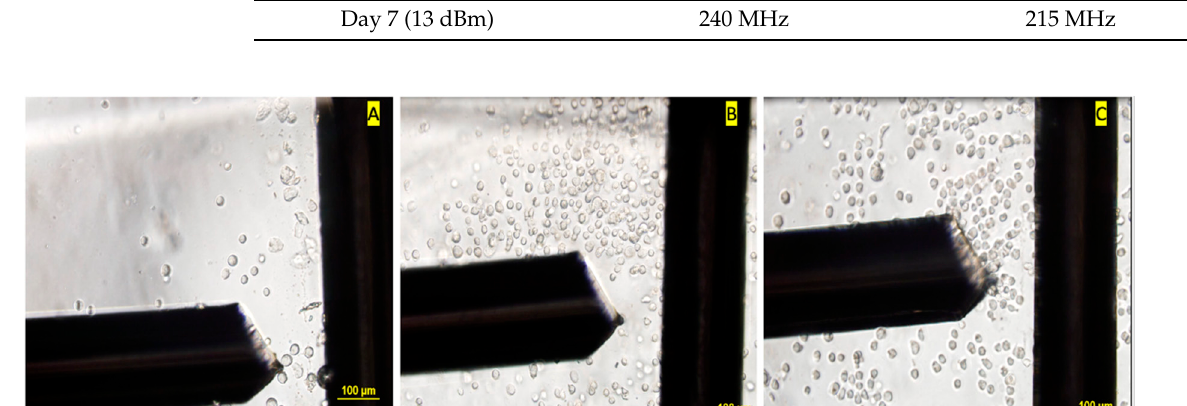
Figure 4. Images describing movement of mesenchymal stem cells (MSCs) away and toward the high electric field region, i.e., negative dielectrophoresis (nDEP) and positive dielectrophoresis (pDEP) for different cell groups. ( A ) Baseline cells– control group experiencing pDEP at 105 kHz and 8 V pp , ( B ) 3 day–no treatment group experiencing nDEP at 110 kHz and 8 V pp , and ( C ) 3 d treatment group with transforming growth factor beta 2 (TGF β 2), i.e., differentiating into tendon cells experiencing pDEP at 200 kHz and 8 V pp .